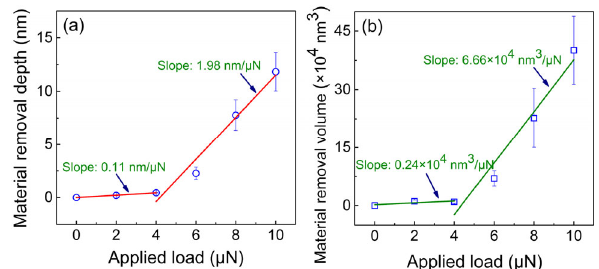
Fig. 3 Corresponding statistical data for the amount of removed material after performing wear tests on the polished pure iron surface against a diamond tip in vacuum. (a) Material removal depth d . (b) Material removal volume V